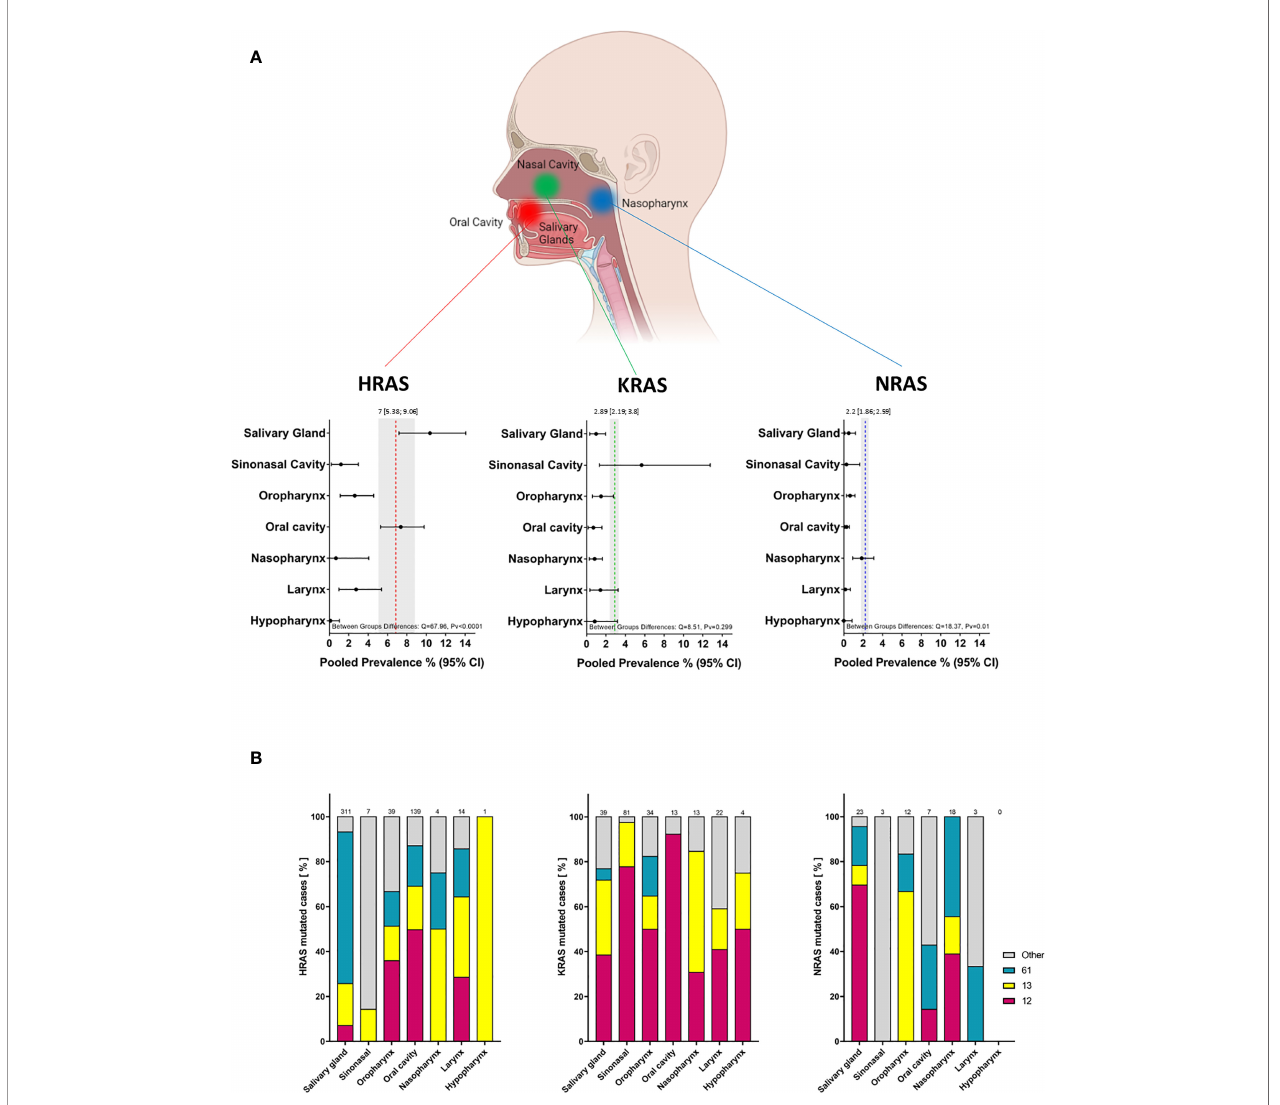
FIGURE 5 | Prevalence of RAS mutations and locations of mutated codons according to tumor anatomical site. (A) Prevalence of RAS mutations according to tumor anatomical site. Dotted lines and gray shading correspond to the overall prevalence and the 95% CI. (B) Mutated codon locations [%] according to tumor anatomical site. CI, Con fi dence interval; I 2 , Inconsistency